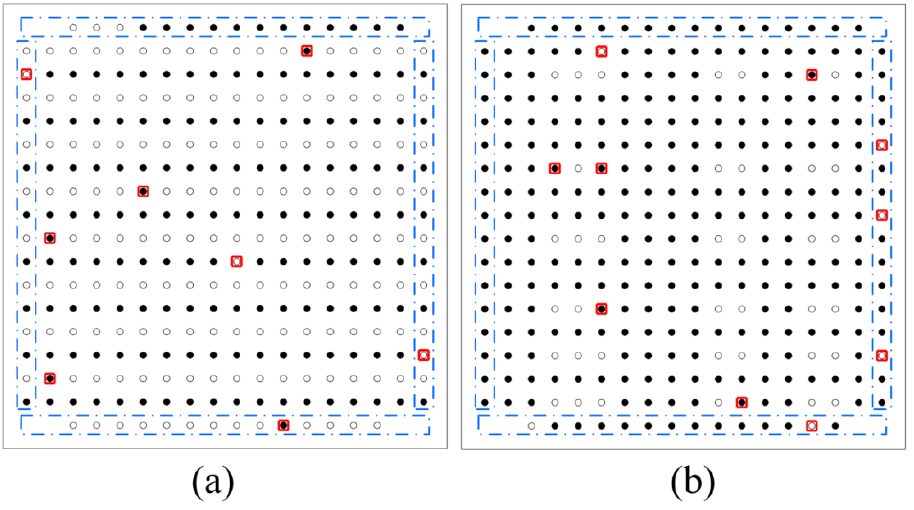
Figure 7. The recognized results of the flip chips.